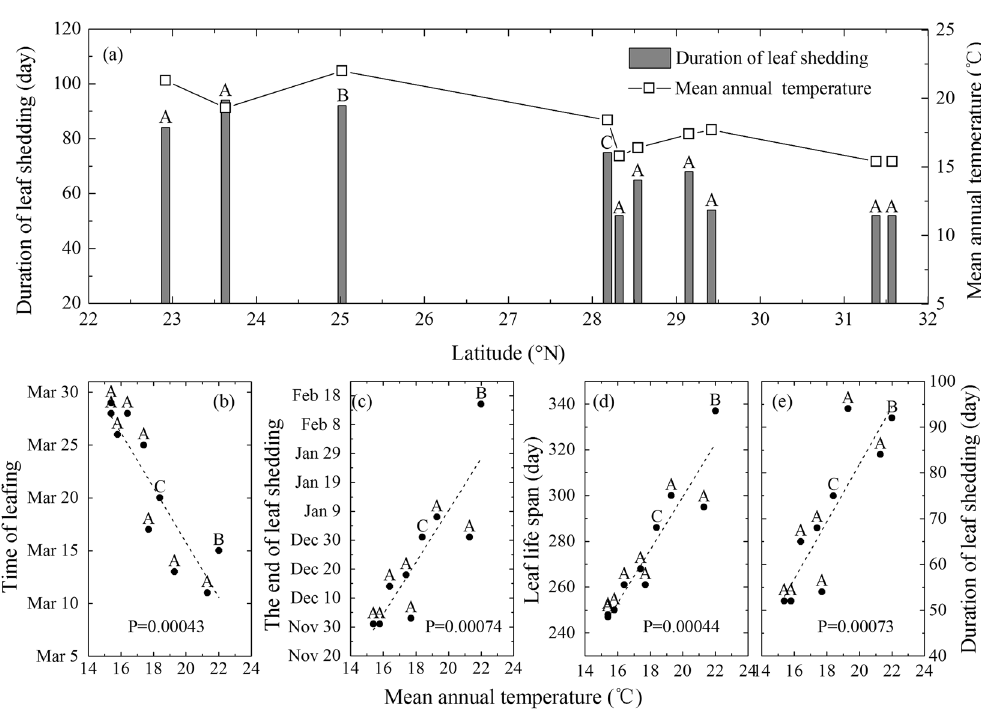
Figure 6. Duration of leaf shedding for Liquidambar formosana among different latitudes in China ( a ), and the scatter plots between time of leafing, the end of leaf shedding, leaf life span, duration of leaf shedding and mean annual temperature ( b – e ). Dash lines in ( b – e ) represent fitted linear relationships, and a P value smaller than 0.05 means the slope is significantly different from zero. The labels (A, B, and C) on the top of the bars in ( a ) and dots in ( b – e ) represent the data sources, A from Wang et al . 52 , B from Wen et al . 42 , and C from this